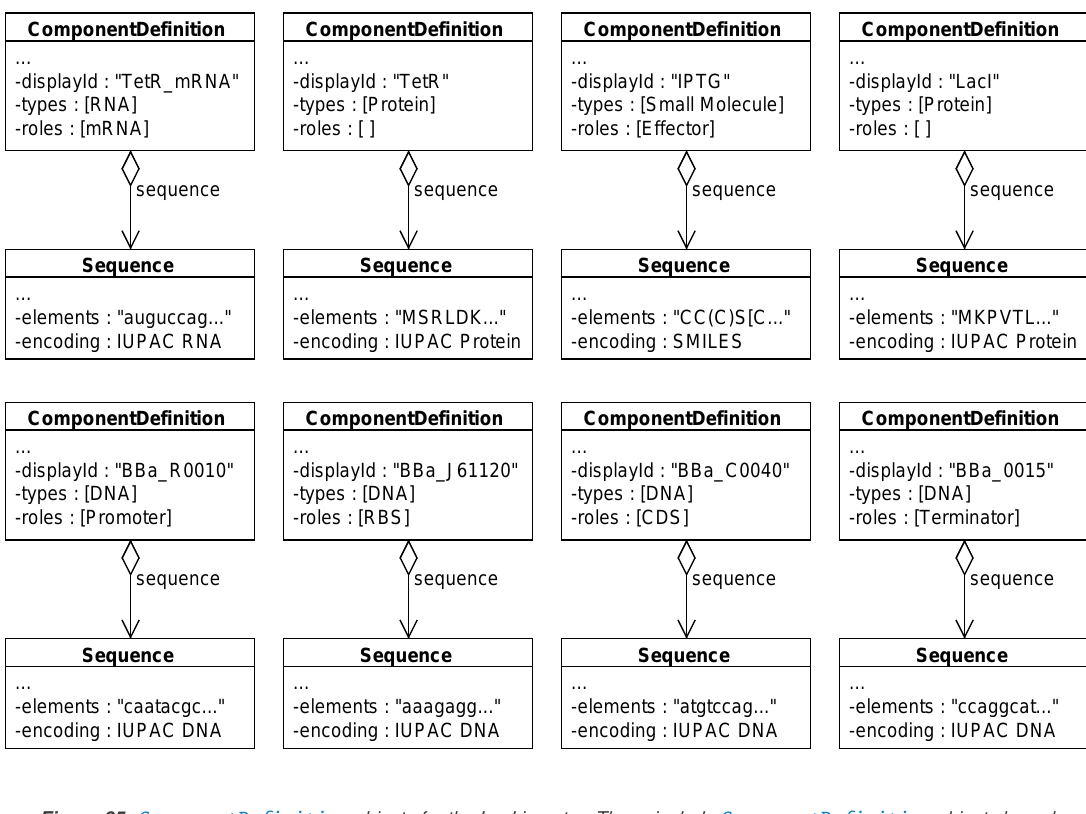
Figure 25: ComponentDefinition objects for the LacI inverter. These include ComponentDefinition objects based on DNA parts from the iGEM Parts Registry and ComponentDefinition objects that represent TetR mRNA, TetR, LacI, and IPTG. Each ComponentDefinition is associated with a Sequence that has an IUPAC DNA/RNA or IUPAC protein encoding , except the ComponentDefinition of IPTG, which is associated with a Sequence that has a SMILES encoding